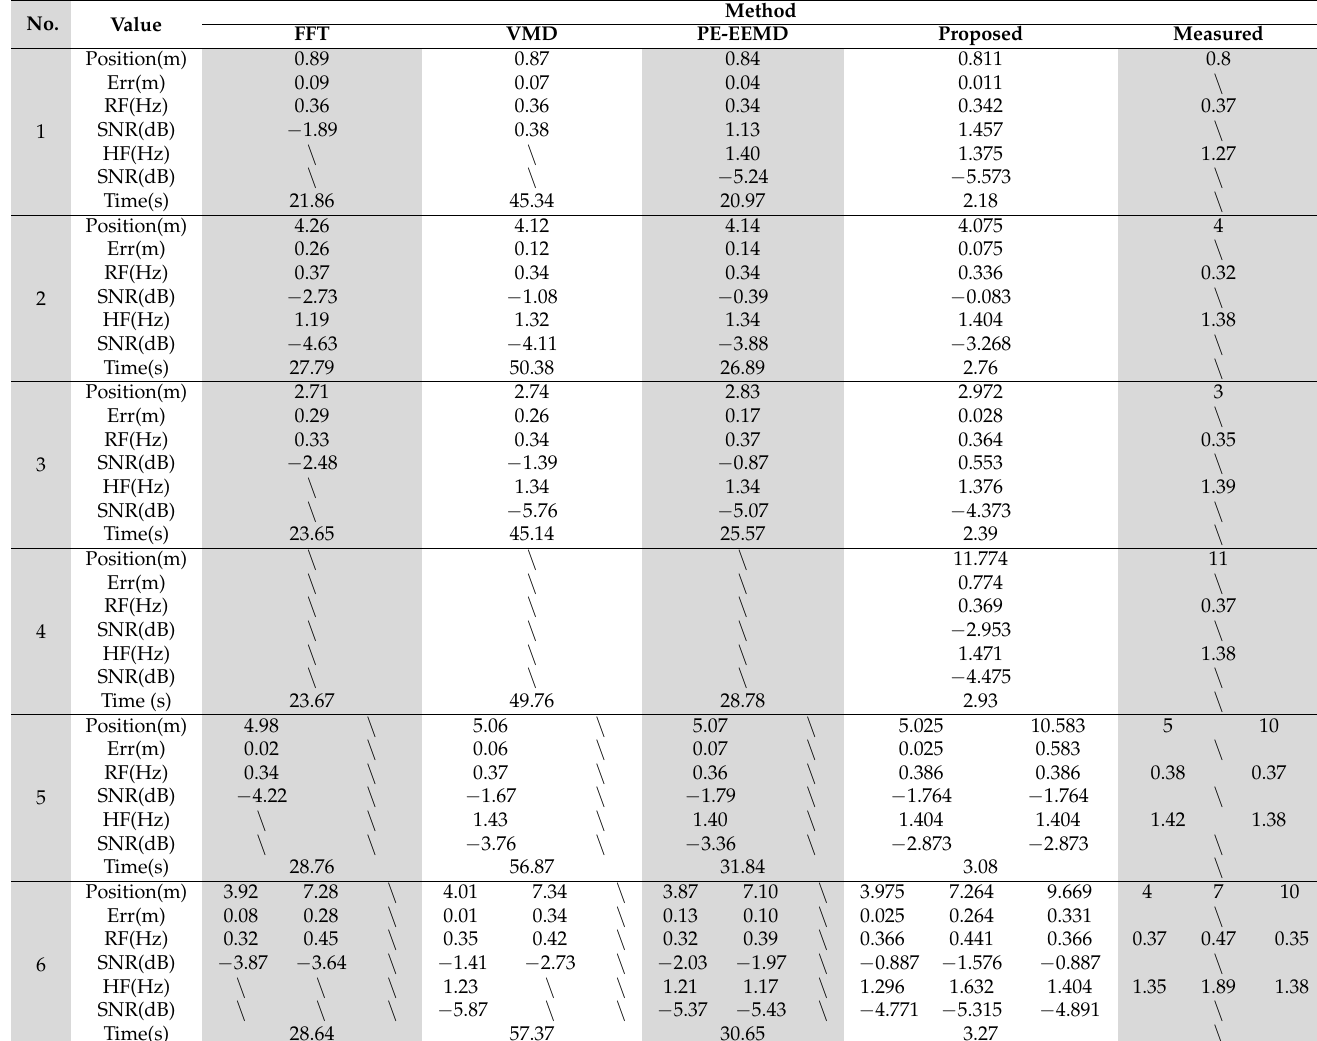
Table 7. Results and performance comparison with the referenced algorithm.